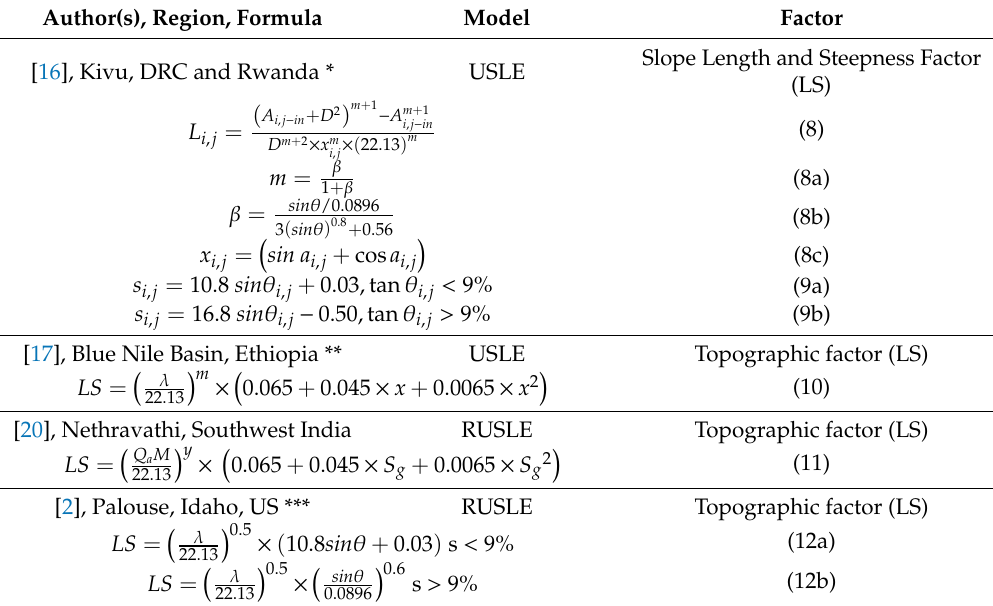
Table A3. Overview of LS factor calculations of selected